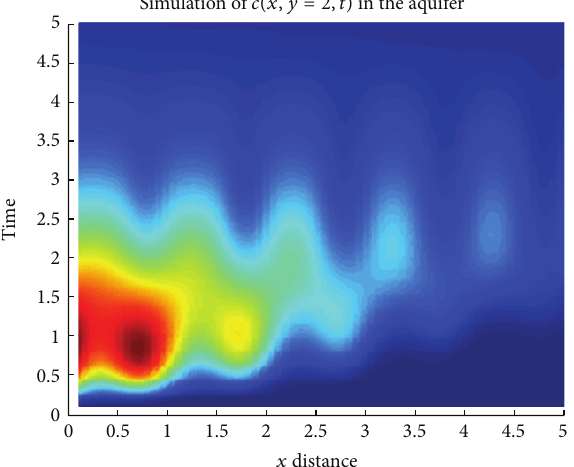
Figure2: Simulation oftheapproximate solution obtained via DTM for a fixed 𝑦 = 2 .